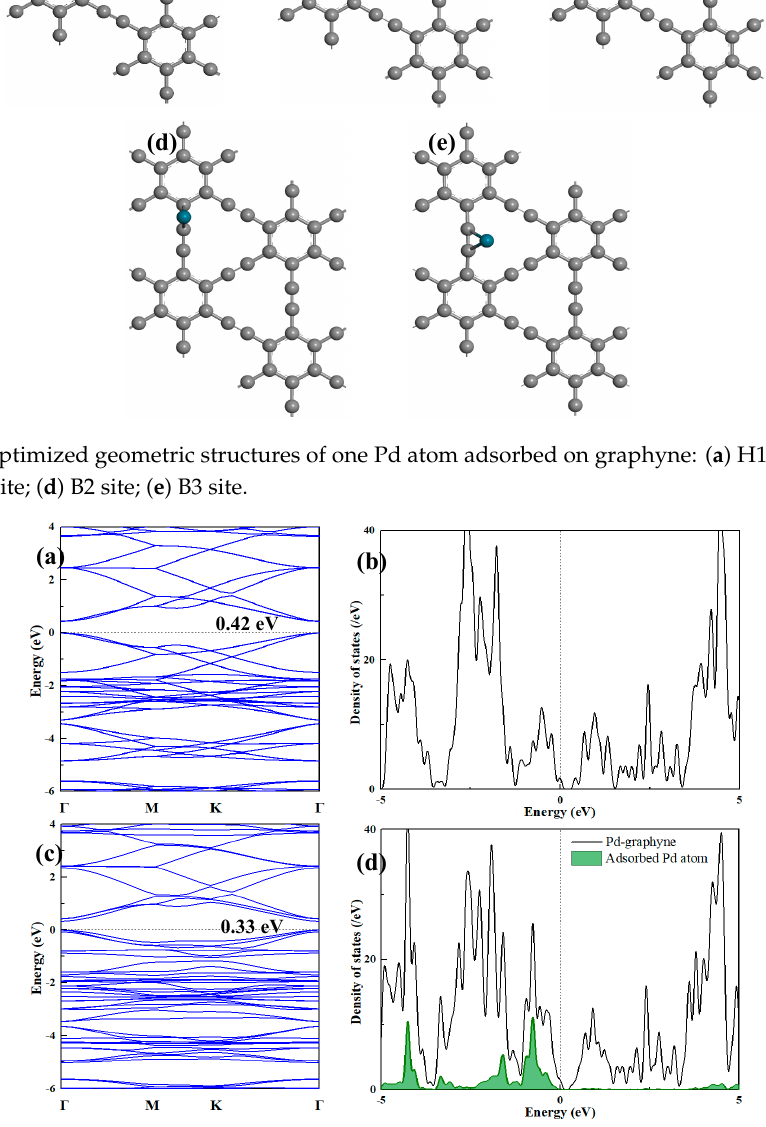
Figure 3. ( a ) Band structure and ( b ) TDOS of pristine graphyne; ( c ) Band structure and ( d ) TDOS of Pd-graphyne and PDOS of adsorbed Pd